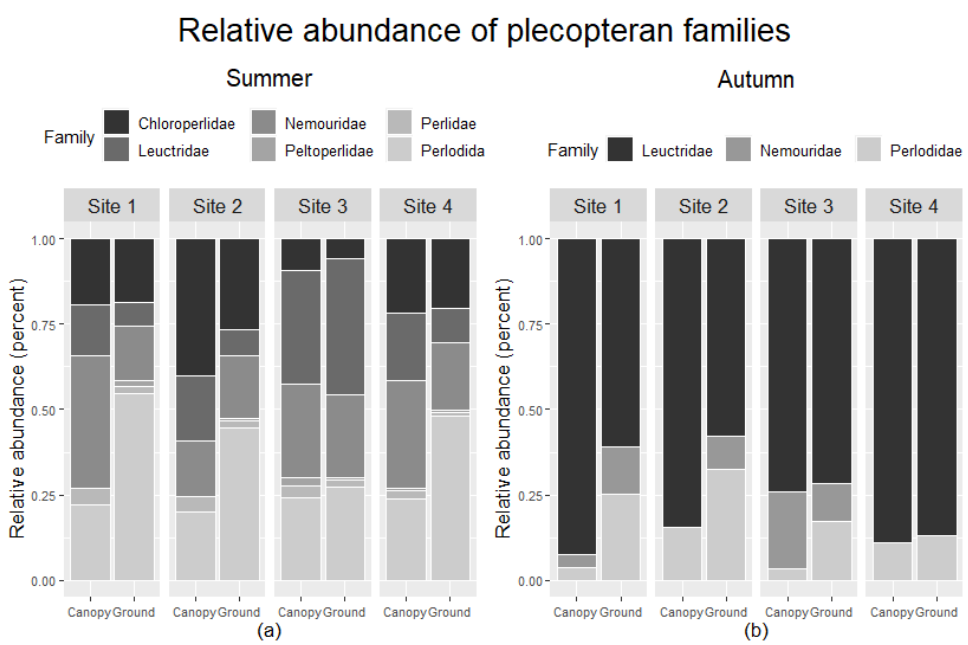
Figure 8. The relative abundance of plecopteran families found in canopy and ground traps among sites for the ( a ) summer and ( b ) autumn collections.